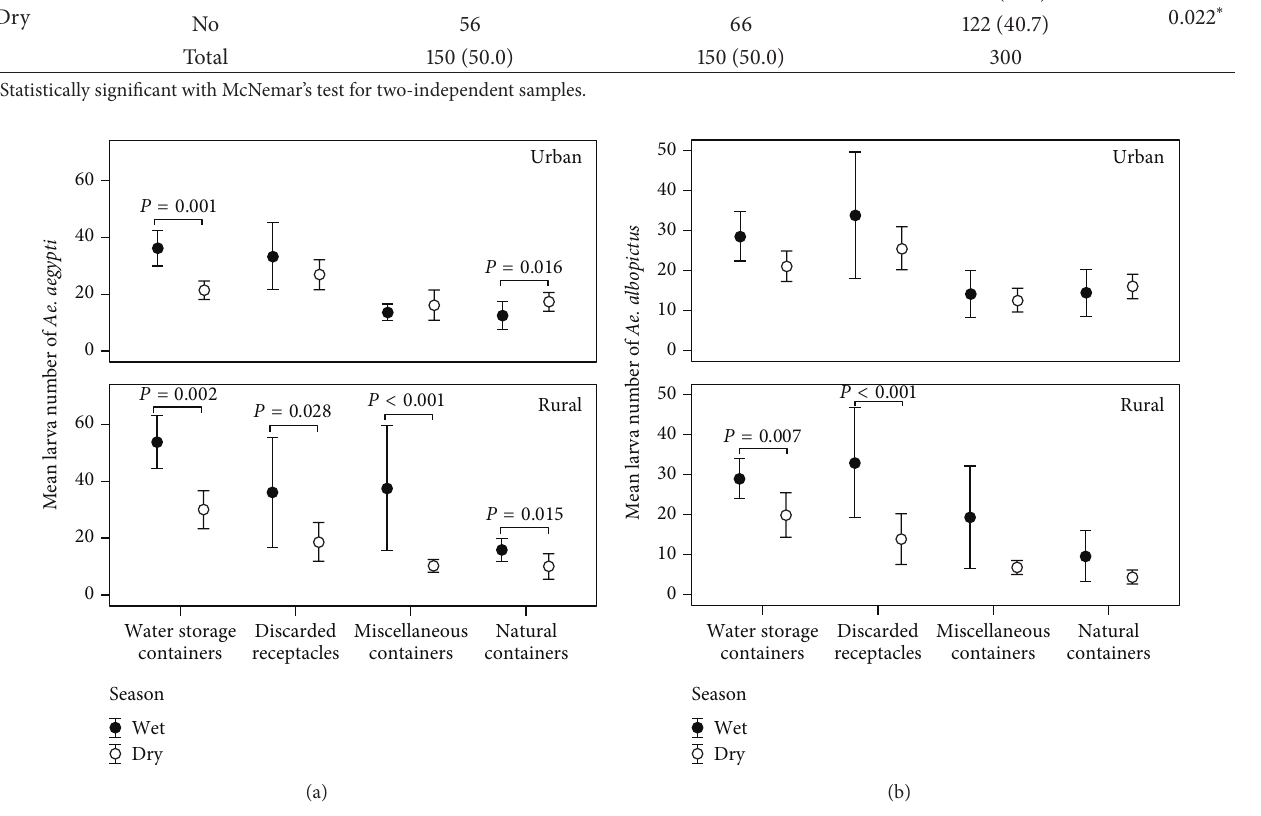
Figure 3: Comparisons of the abundance of Ae. aegypti and Ae. albopictus in each container type by season. The abundance of Aedes vectors was presented by mean larva numbers ( ± 2 SE) of Ae. aegypti (a) and Ae. albopictus (b) as denoted by error bars. Only the outdoor distributions of Aedes larva numbers in any key containers were further analyzed by the independent observations between two seasons in two study settings. In the urban-rural gradient, the equal distributions of Aedes larvae independently observed between seasons were tested using the Mann-Whitney 𝑈 test; the only two-independent samples that provided statistically significance ( 𝑃 < 0.05 ) are